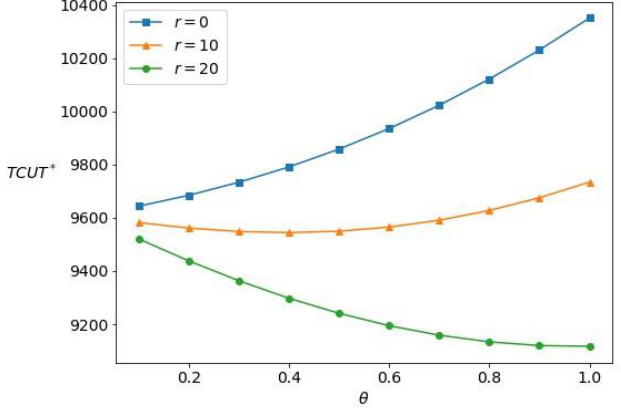
Fig. 4. Change of TCUT with respect to θ for various r .